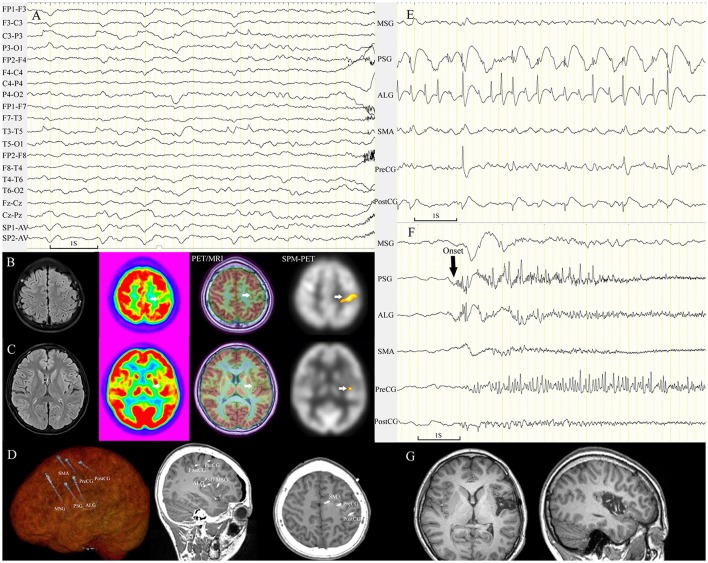
Patient 21 with FCD tended to be mislocalized by conventional visual analysis of PET images. The semiology of the 13-year-old girl was nocturnal dystonic posturing of the left limbs, numbness in the left arm with ambiguous localization before rare diurnal seizures. Scalp EEG showed periodic sharp-slow wave complexes on channel C3-P3 and T3-T5 before seizure onset (A). MRI scans were negative. Focal hypometabolism in the left parietal lobe was identified by conventional visual analysis (B), which was nonconcordant with the ambiguous localization of the numbness and epileptic waves on channel T3-T5. PET/MRI and SPM-PET demonstrated mild hypometabolism in the central sulcus of the left insula (C). Intracranial electrodes were implanted for coverage of the left insular and central areas (D). Interictal SEEG recording showed that continuous, repetitive spikes arose from the left PSG and ALG and spread to the central area (E). Ictal data showing seizures (10 onsets during SEEG monitoring) originating from the left PSG (F). The left PSG, ALG, and PLG were removed (G); the pathological finding was FCD IIA, and the patient was seizure-free through the last follow-up at 21 months. ALG, anterior long gyrus; PLG, posterior long gyrus; PostCG, postcentral gyrus; PreCG, precentral gyrus; PSG, posterior short gyrus.